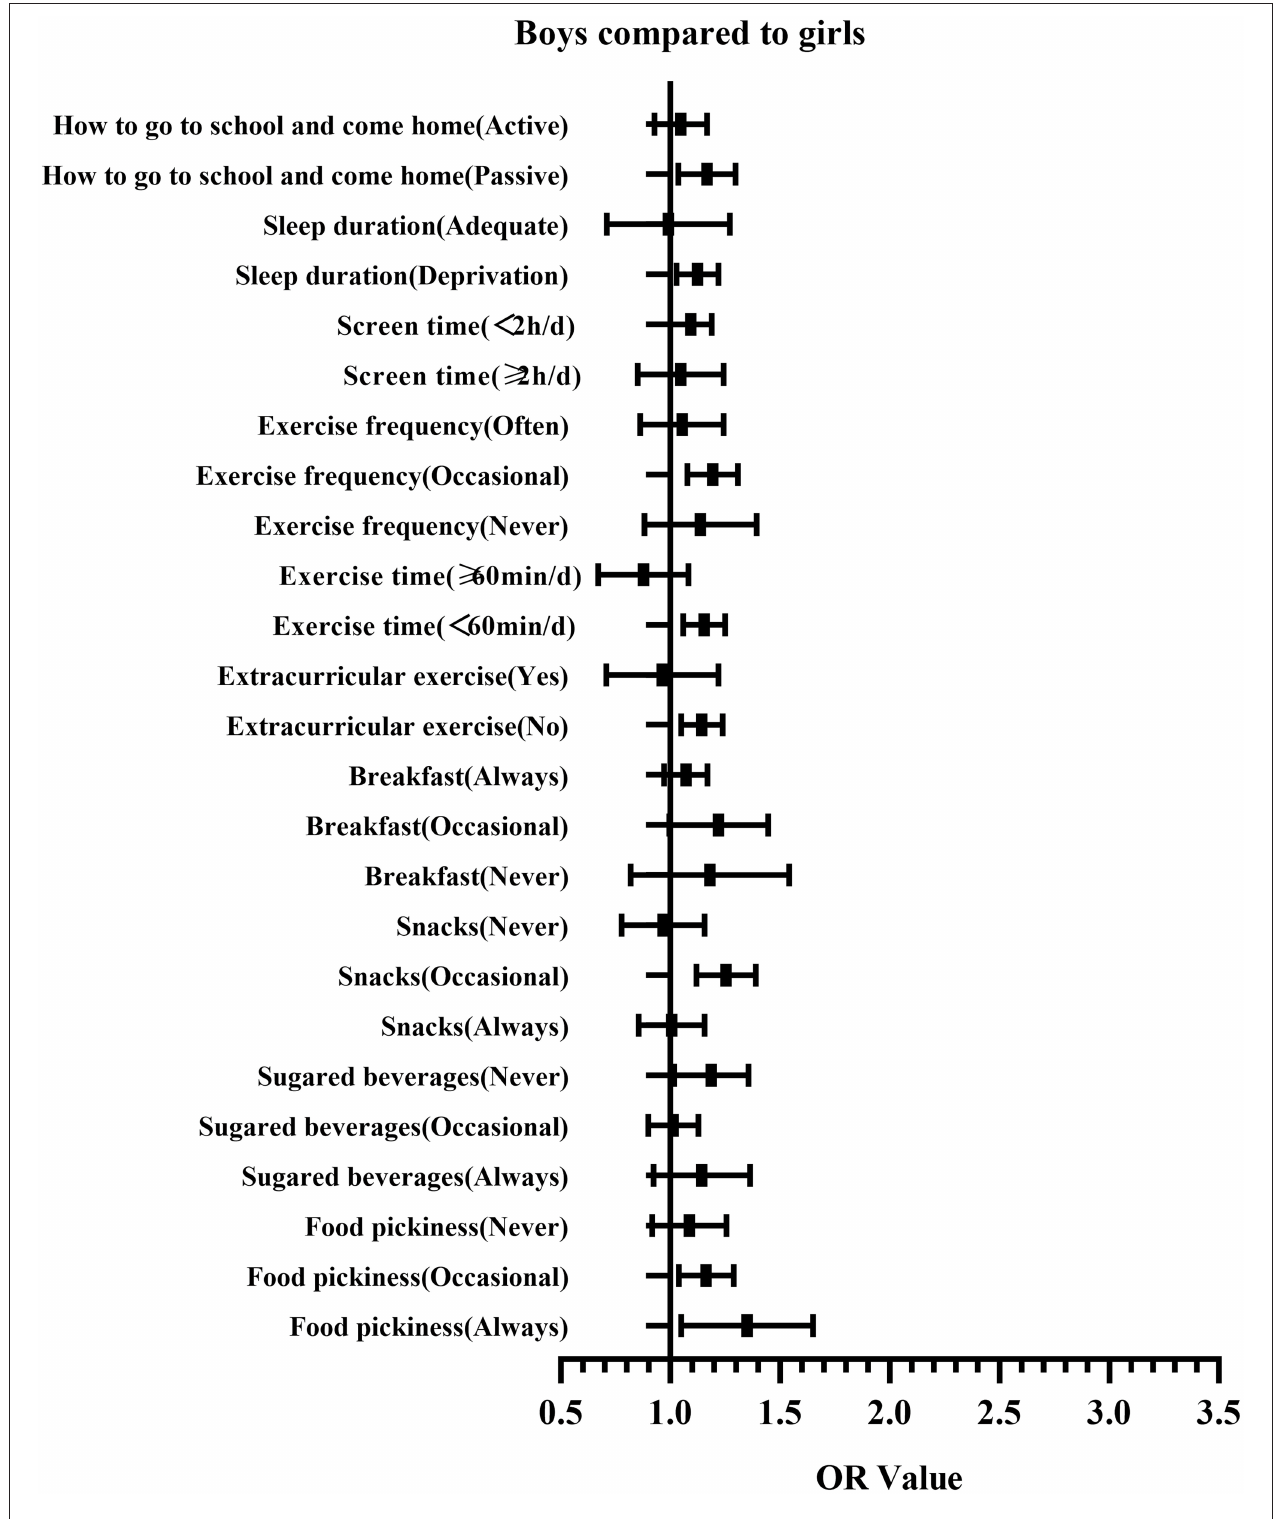
FIGURE 3 | Gender comparison on the correlation between psychological symptoms and lifestyles for Chinese middle school students.